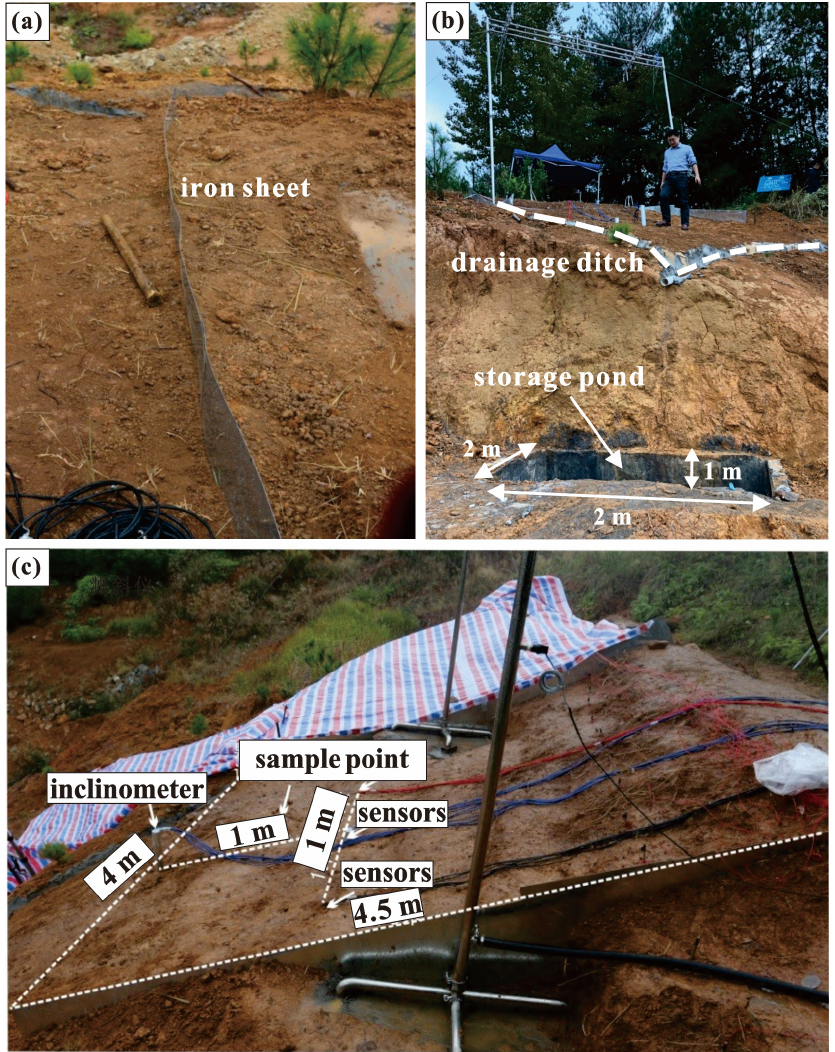
Figure 2. Layout of the experimental site of the landslide: ( a ) Iron sheets set on the site as boundaries; ( b ) Drainage and storage pool; ( c ) Rainfall area of the experimental site.